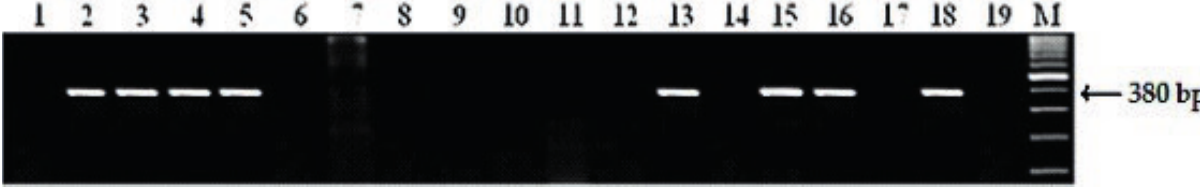
Figure 1. DNA amplification products for wheat cultivars and elite lines obtained with diagnostic marker Xfcp623 linked to the Tsn1 gene sensitive to Ptr ToxA. Lane: 1, GF_3_CP; 2, GF_9_CP; 3, 10205_3KSI; 4, 631_SP2; 5, 634_SP2; 6, 1_PSI; 7, Daulet; 8, Dinara; 9, Streletskaya